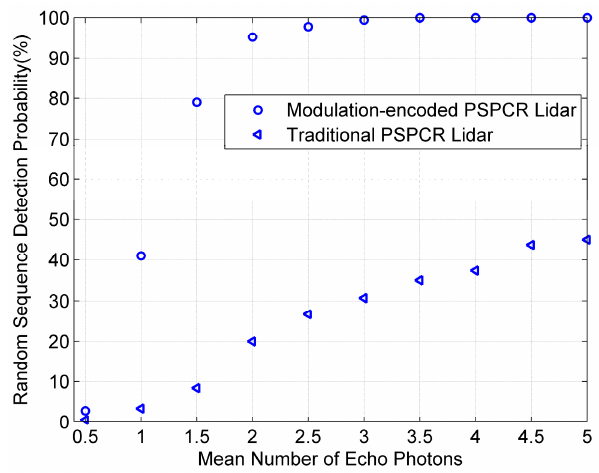
Figure 10. The detection probability statistical results of the modulation-encoded PSPCR Lidar and the traditional PSPCR Lidar at different mean echo photon number.